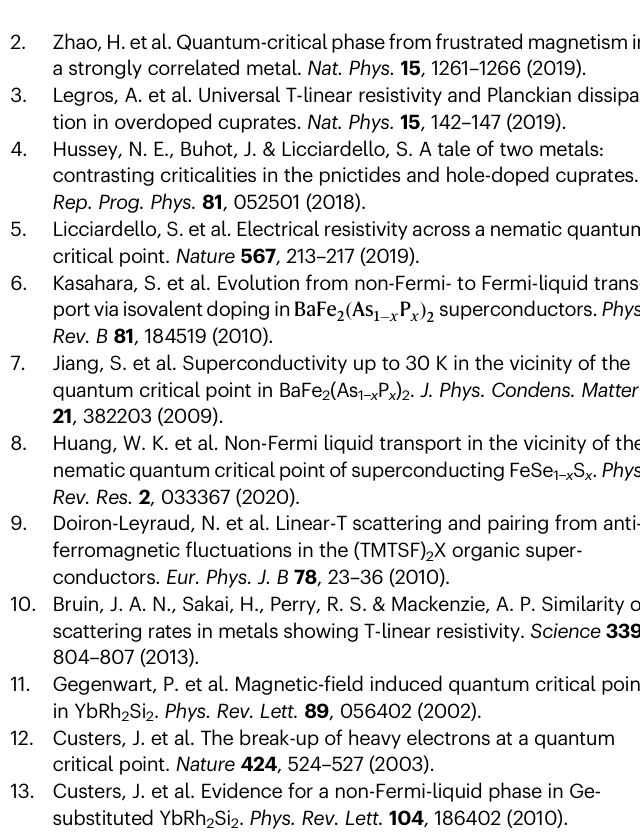
Fig. 4 | Speci fi c heat coef fi cient C / T and its T / B scaling. a , b show the electronic speci fi c heat coef fi cient C / T versus T / T LFL with different fi elds B ∥ c for 0.02,and 0.05,respectivelywhile c and d display the power-law T / B scaling of a and b . Here,